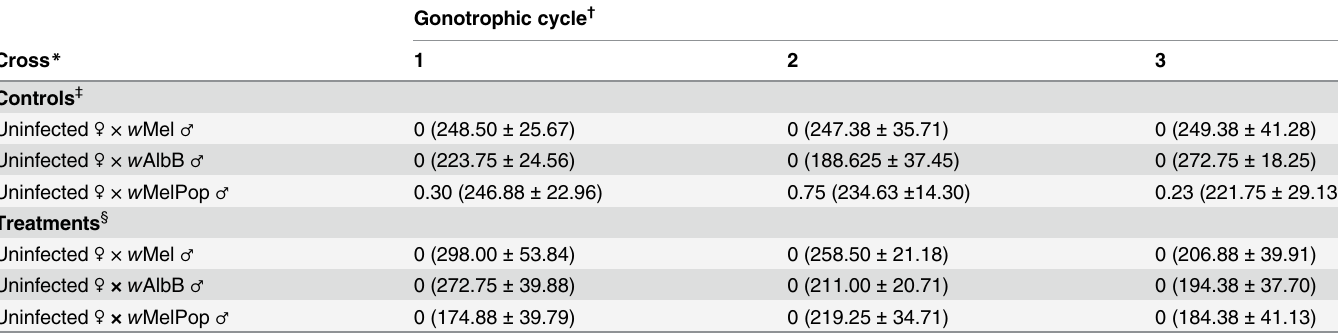
Table 5. Percentage of hatching eggs from crosses between Wolbachia -infected males and uninfected female Ae . aegypti . Gonotrophic cycle †